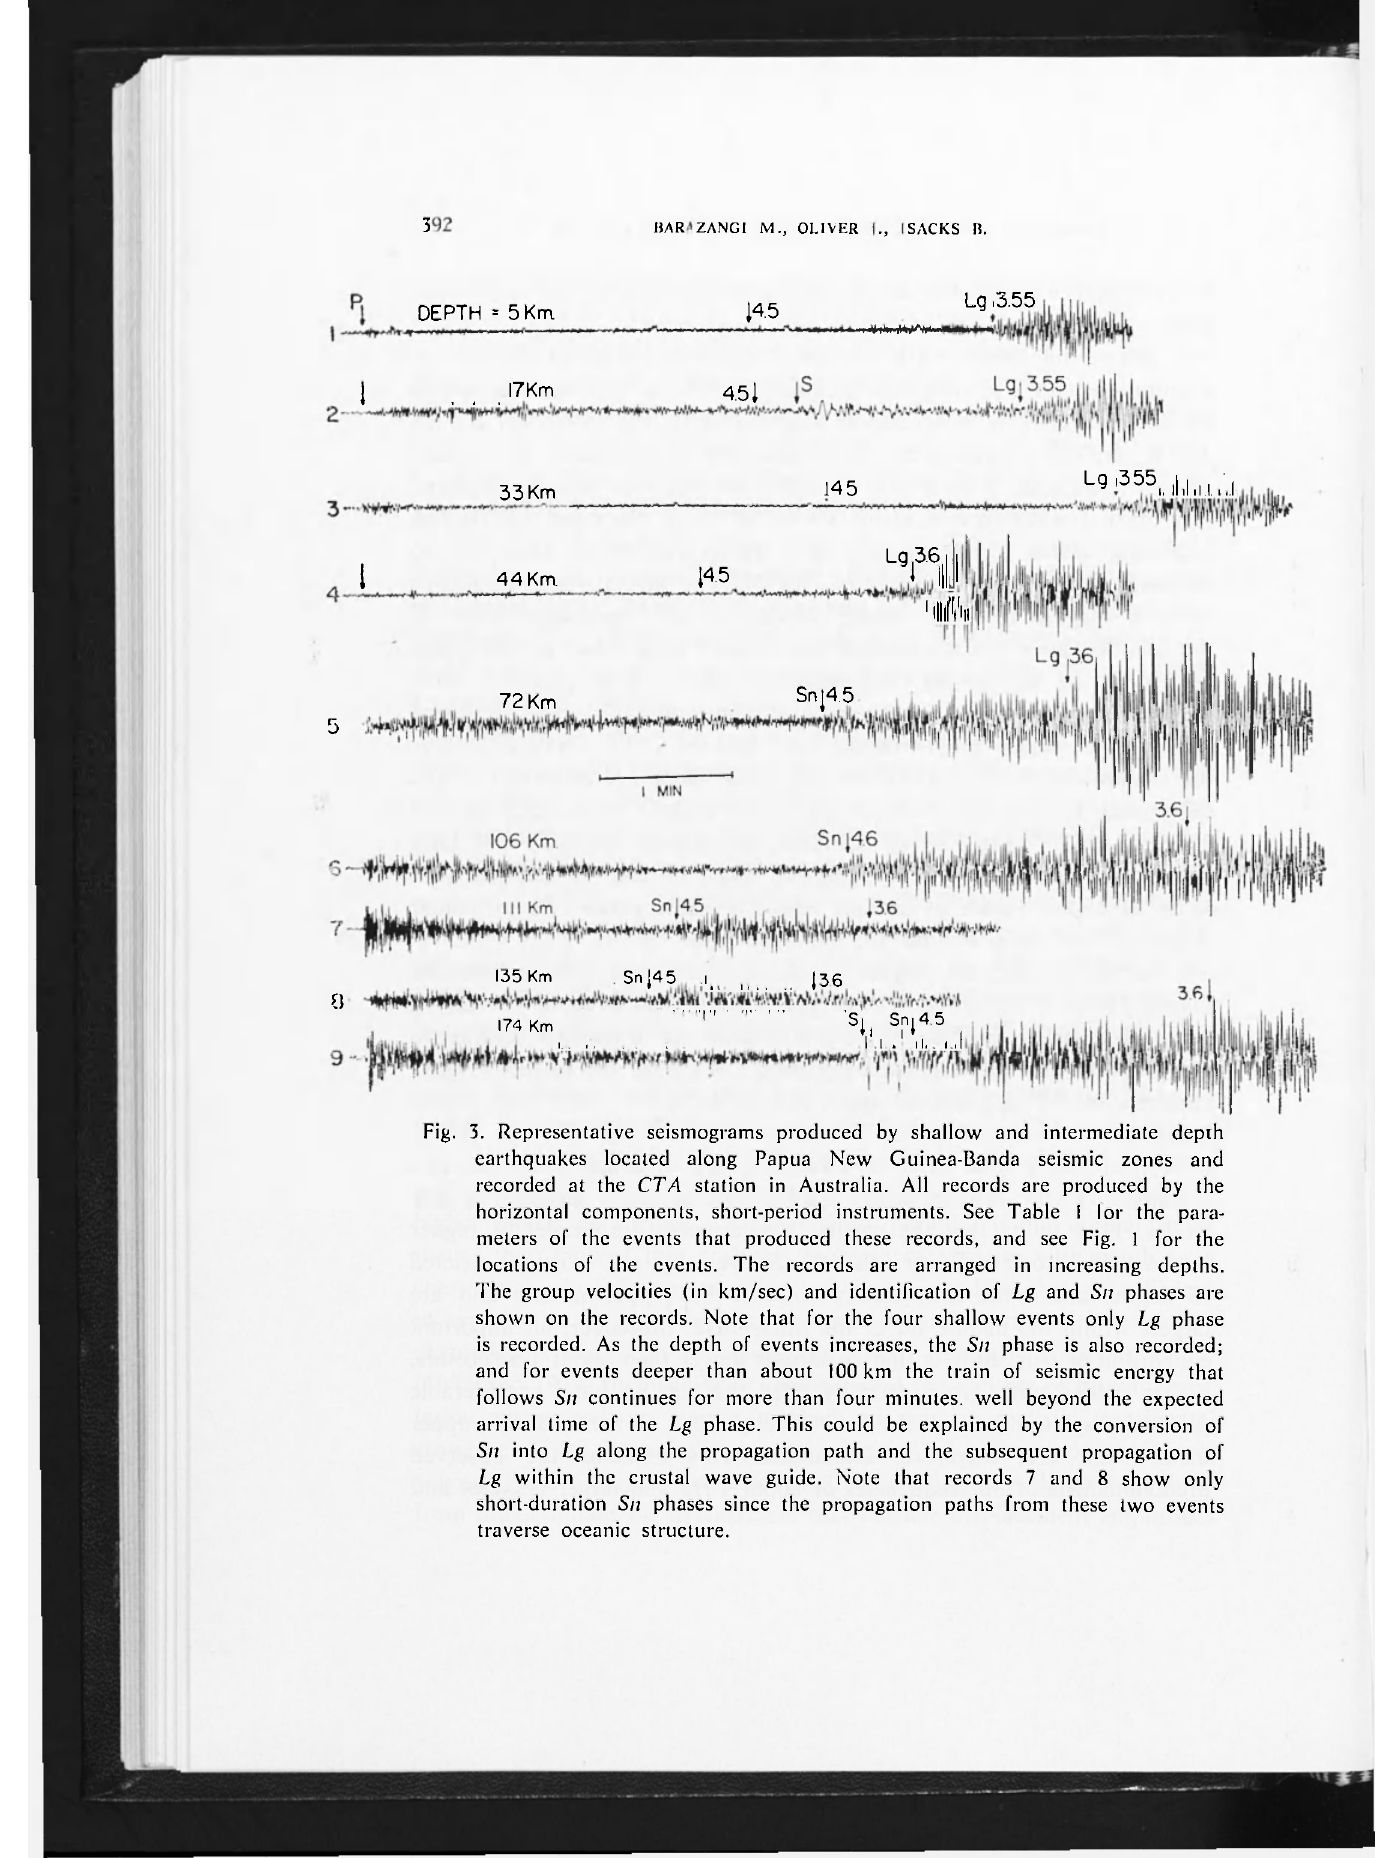
Fig. 3. Representative seismograms produced by shallow and intermediate depth earthquakes located along Papua New Guinea-Banda seismic zones and recorded at the CTA station in Australia. All records are produced by the horizontal components, short-period instruments. See Table I lor the para- meters of the events that produced these records, and see Fig. 1 for the locations of the events. The records are arranged in increasing depths. The group velocities (in km/sec) and identification of Lg and Sn phases are shown on the records. Note that for the four shallow events only Lg phase is recorded. As the depth of events increases, the Sn phase is also recorded; and for events deeper than about 100 km the train of seismic energy that follows Sn continues for more than four minutes, well beyond the expected arrival time of the Lg phase. This could be explained by the conversion of Sn into Lg along the propagation path and the subsequent propagation of Lg within the crustal wave guide. Note that records 7 and 8 show only short-duration Sn phases since the propagation paths from these two events traverse oceanic